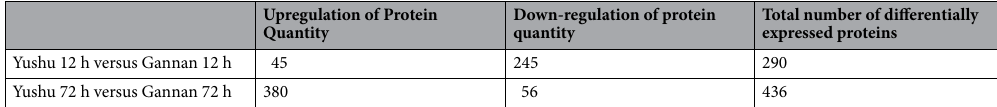
Upregulation of Protein Quantity